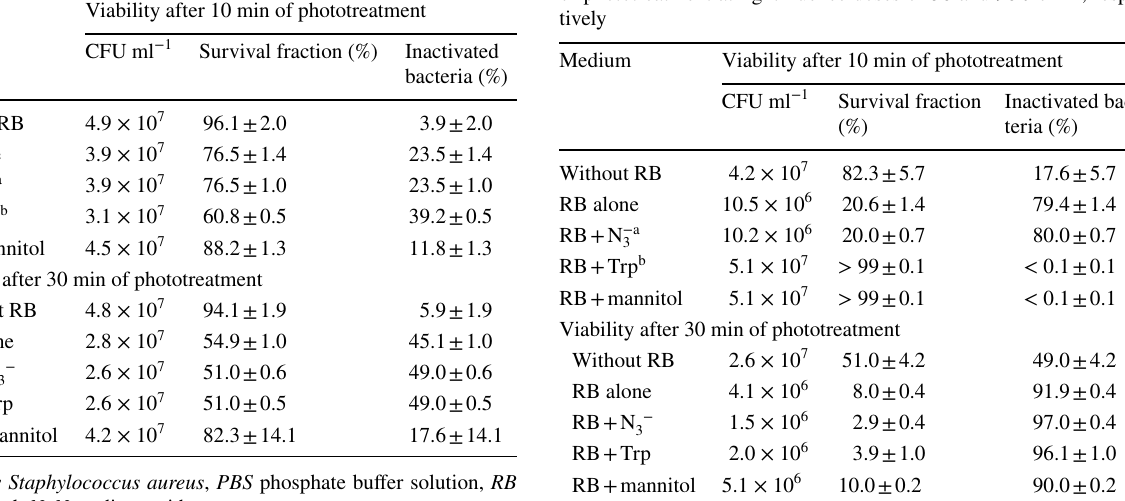
Table 1 Photoinactivation of S. aureus cultures in PBS (pH 7.3) in the dark with RB (20 µM) after 10 and 30 min in the presence of three antioxidants (10 mM): NaN 3 , Trp and mannitol